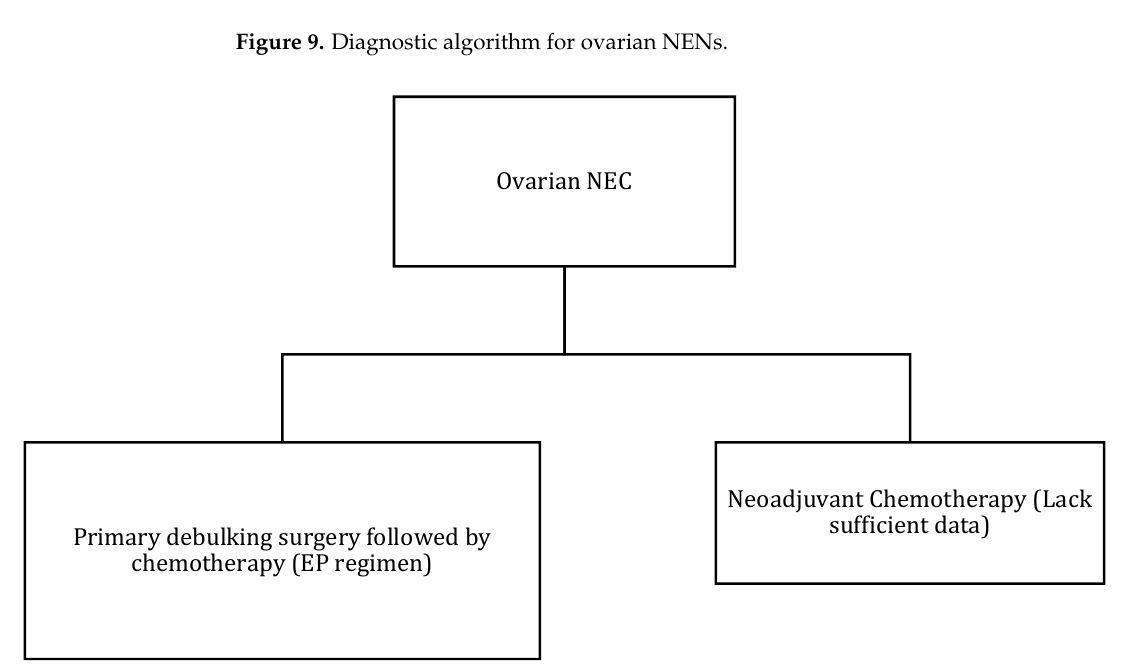
Figure 10. Treatment algorithm of ovarian NEC. If non-surgical or metastatic disease: palliative chemotherapy (EP regimen) or enrollment into clinical trials.